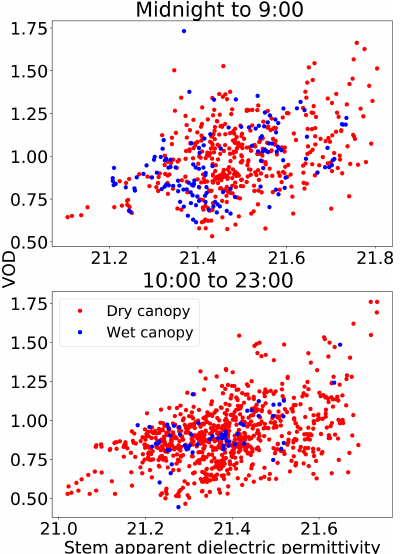
Figure 8. Scatter plots of VOD vs. stem permittivity, colored by canopy wetness. Measurements after 17 September were excluded from this analysis because of a large change in the shape of the VOD–dielectric relationship at that time, as discussed in Sect.